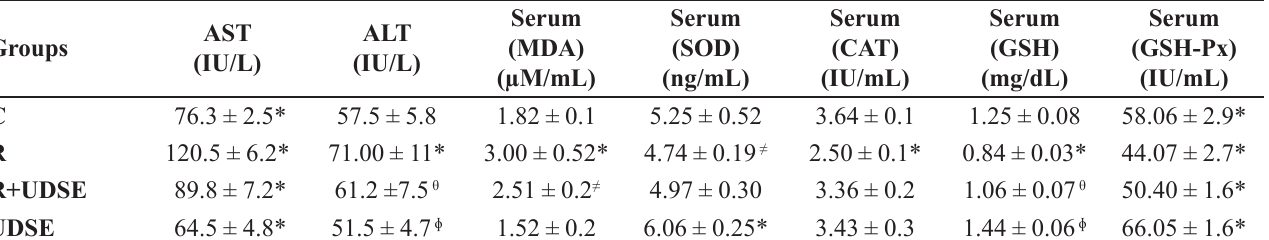
TABLE I - Protective effects of UDSE on selected antioxidant enzyme activities and AST, ALT, MDA levels in the serum of rats